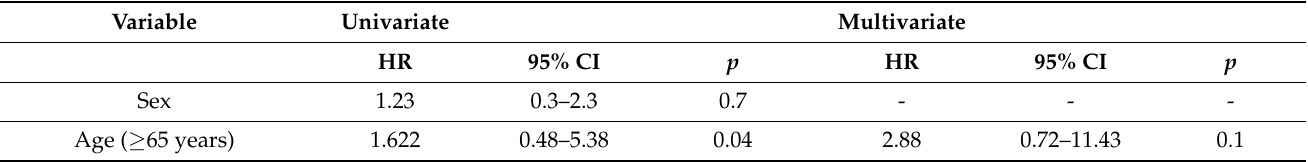
Table 2. Univariate and multivariate analysis of prognostic factors for overall survival.